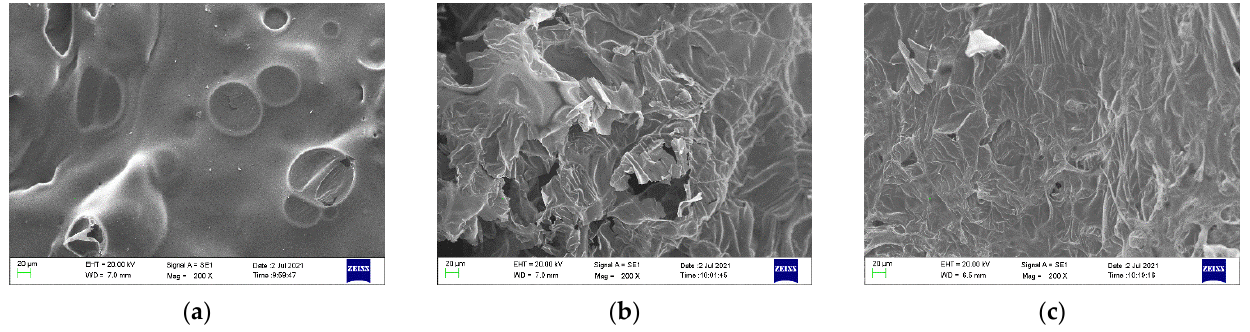
Figure 9. SEM of char residues of pure EP and EP composites, ( a ) EP, ( b ) EP/16IFR, and ( c ) EP/14IFR/2Ba.